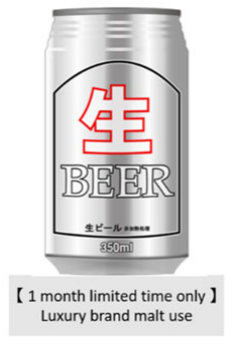
Figure 2. Canned beer B image Figure 3. Canned beer C